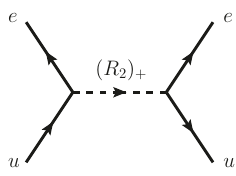
Figure 4 . Tree level leptoquark exchange diagram contributing to the S-PS